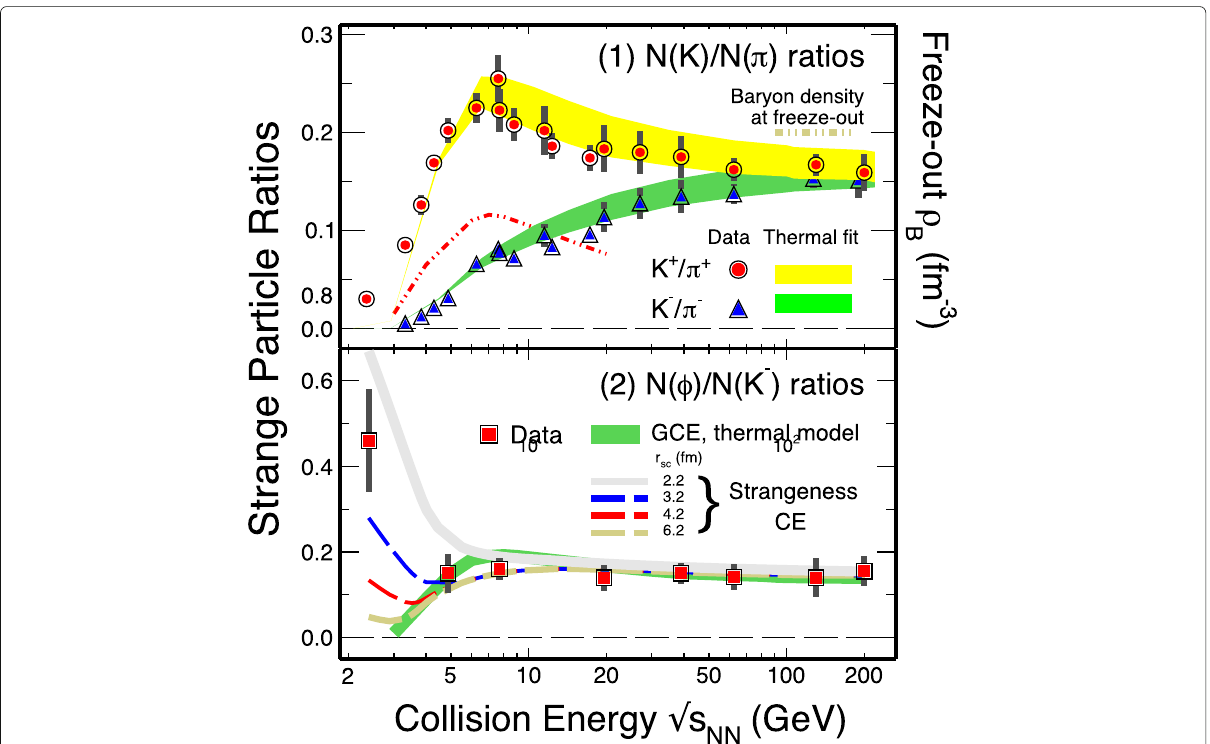
√ Fig. 4 a Particle yield ratios of kaons to pions as a function of s NN . Thermal fits are also shown as bands in the plot. The dot dashed line represents the net-baryon density at the chemical freeze-out. K + /π + (circles) trace the baryon density at the chemical freeze-out well, while K − /π − (triangles) √ √ s NN . b Particle yield ratios of φ -meson to kaon ( φ/ K − ) as a function of s NN . At energy below 8GeV, the GCE fit increase smoothly as a function of no longer works, and the strangeness CE takes over